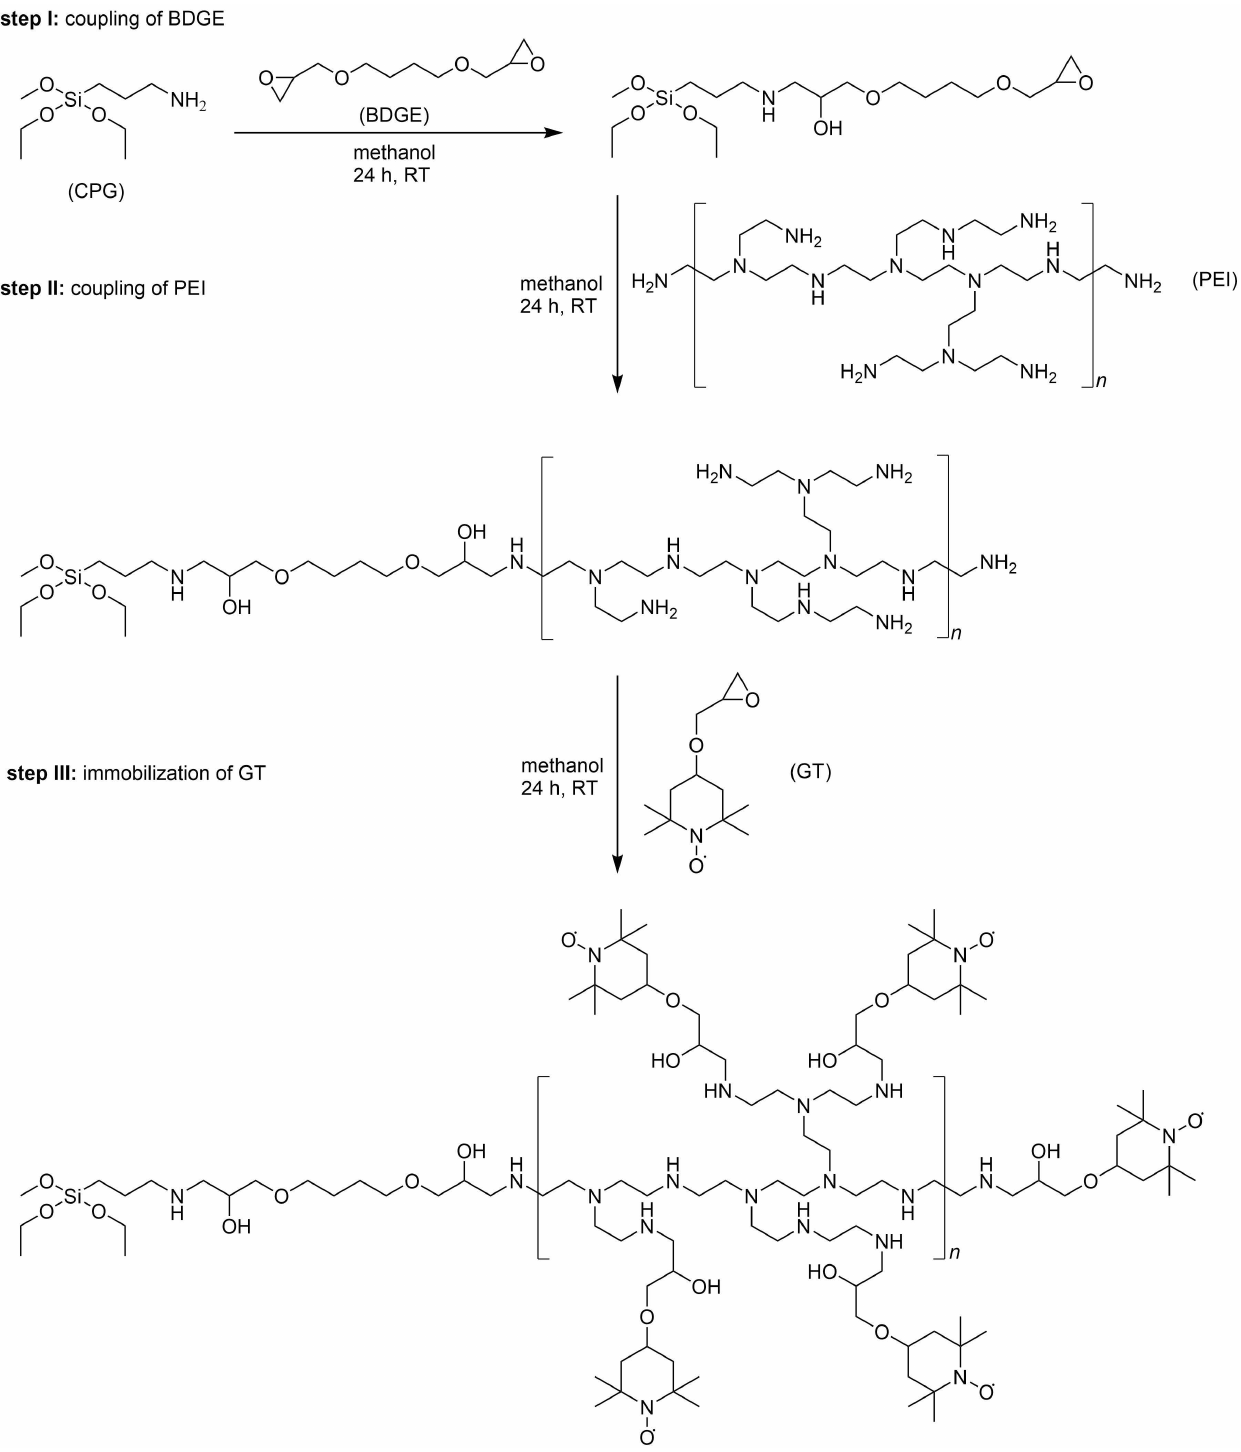
Figure 1. Scheme of the three-step immobilization procedure: (1) coupling of BDGE on aminopropyl- functionalized CPGs; (2) coupling of PEI on glycidyl-functionalized CPGs; (3) immobilization of GT. In this work, radical matrices with immobilization of GT directly on the surface of aminopropyl- functionalized CPGs (only step III) and with immobilization indirectly on CPGs with BDGE-linker and PEI-linker were synthesized (step I to step III). All reactions were solely performed at room temperature (RT) in